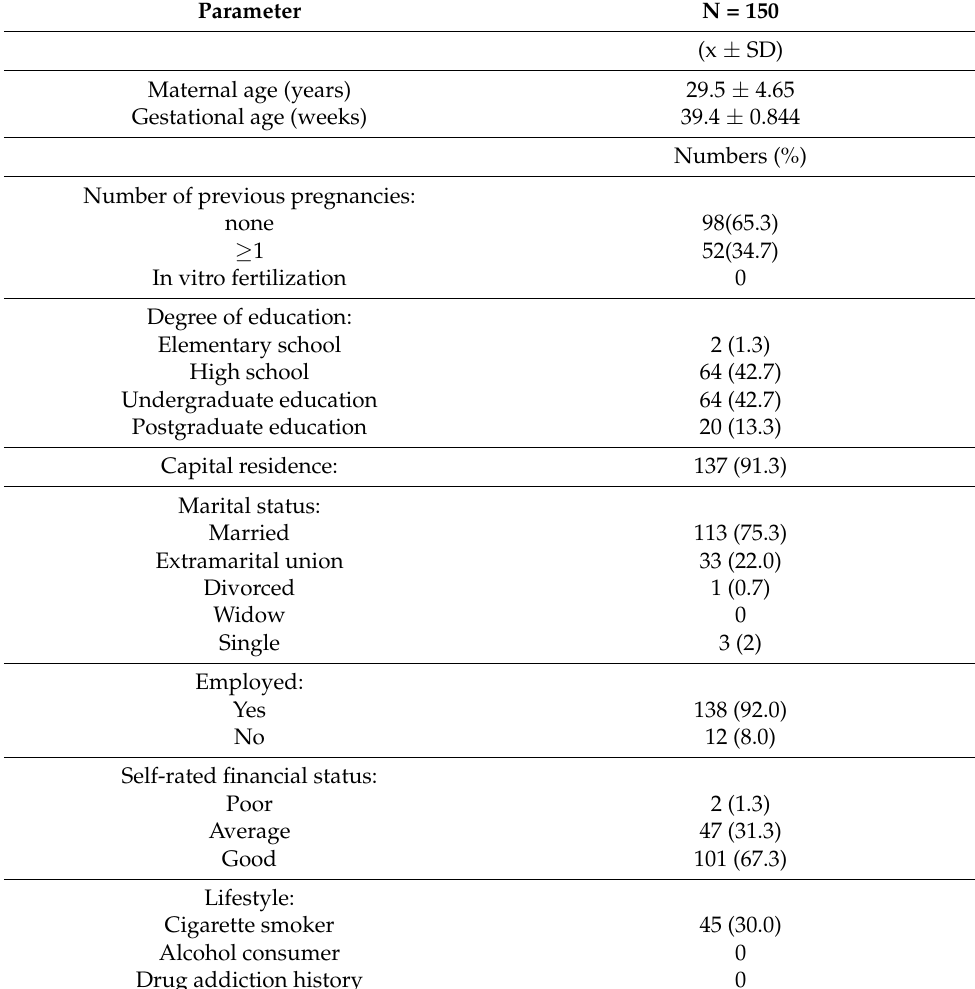
Table 1. Descriptive data of the basic parameters for the pregnant women enrolled in the